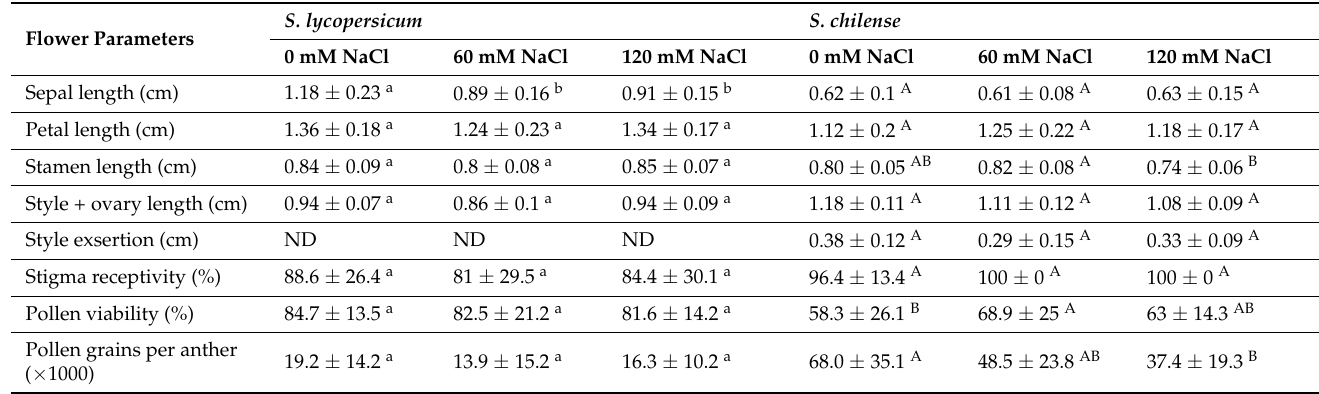
Table 2. Effects of salt stress on flowering morphology and fertility of Solanum lycopersicum and Solanum chilense grown at 0, 60, and 120 mM